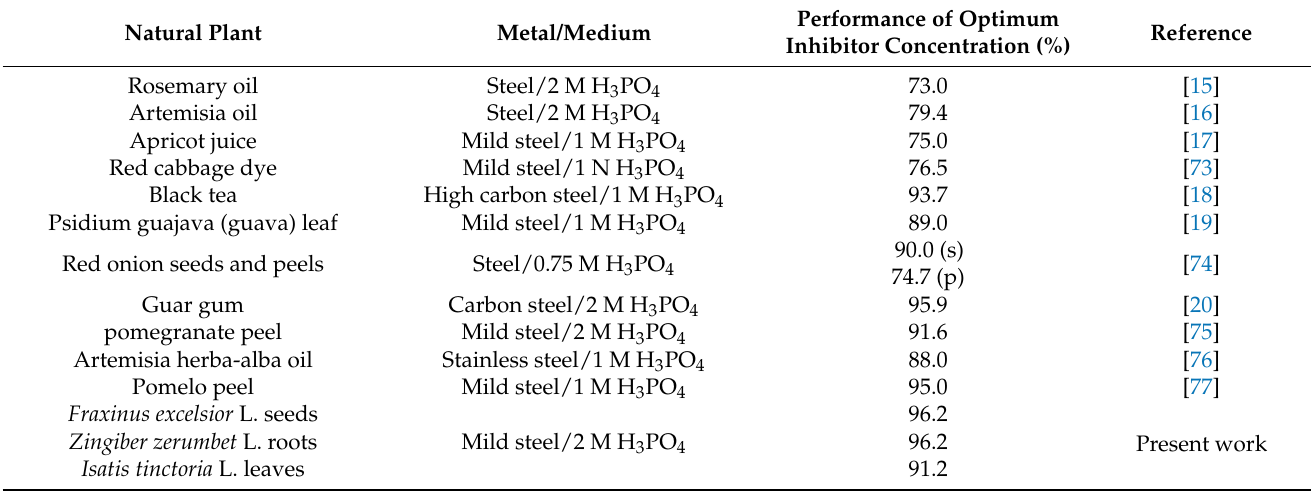
Table 8. Quantitative comparison of the inhibition performance of plant extracts under study with the literature data based on plant extracts studied previously as inhibitors in phosphoric